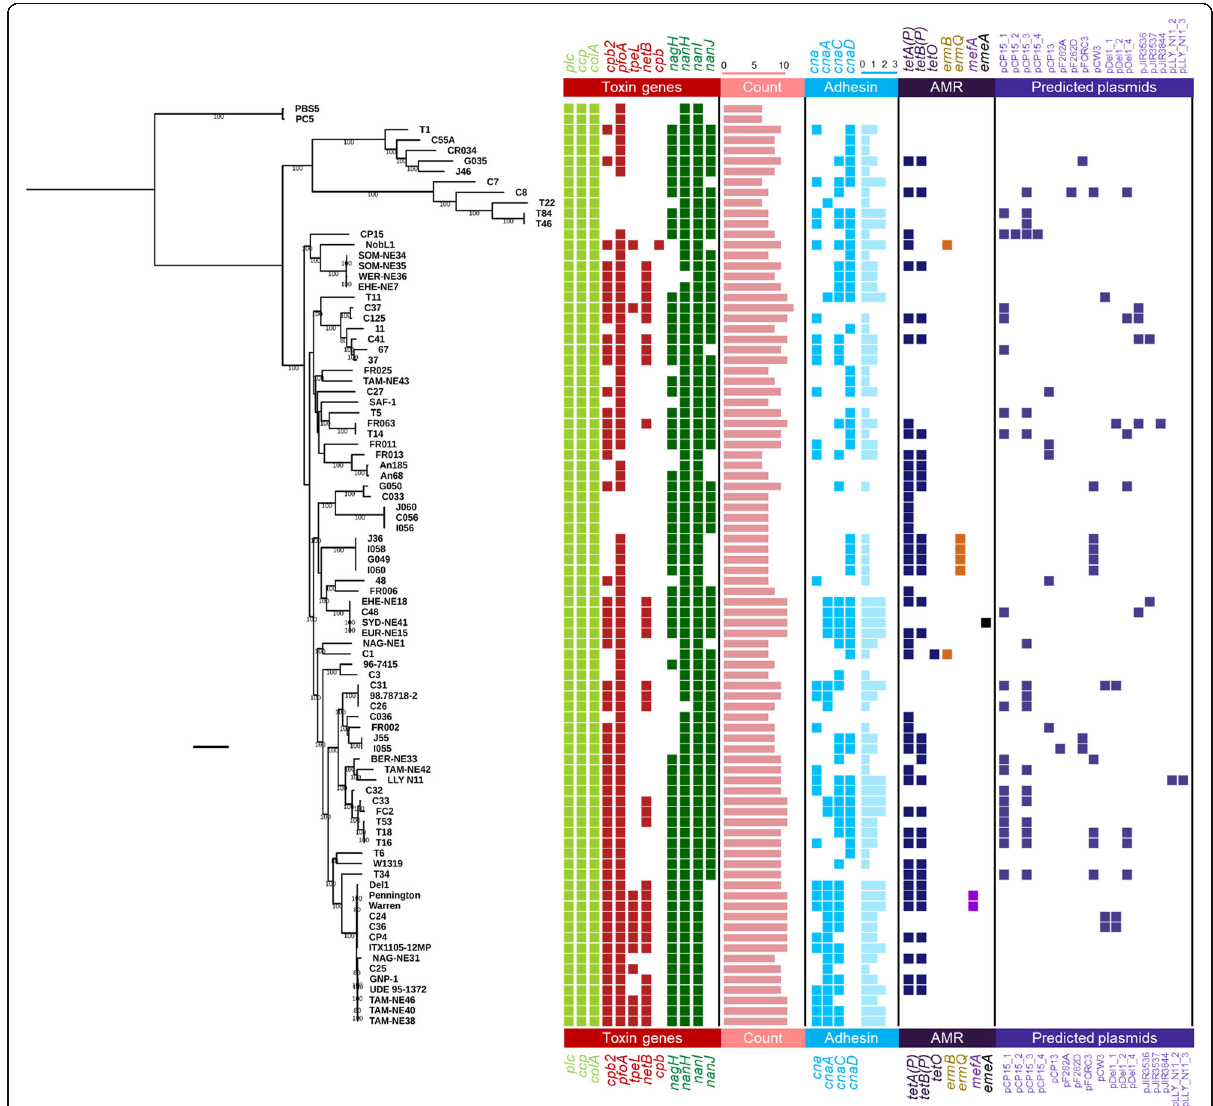
Fig. 3 Mid-point rooted maximum-likelihood tree based on 20,194 SNPs from 1810 core genes aligned with key virulence and resistance determinants, and predicted plasmids present in each genome for 88 broiler-associated C. perfringens . Coloured cells indicate predicted presence of genes/plasmids. AMR: Anti-Microbial Resistance. Scale bar, ~ 2000